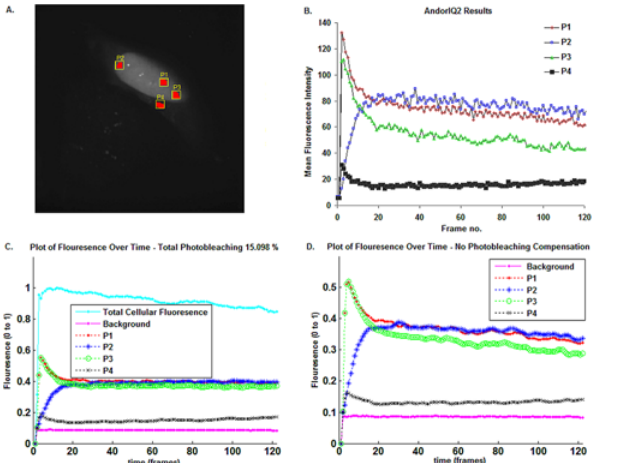
Fig 7. Comparison of Dendra2UBC9 protein trafficking obtained for both AndorIQ2 and MATtrack software. (A) The selected ROIs; (B) Dendra2UBC9 trafficking in HeLa cells analyzed using AndorIQ2; (C) The same sample analyzed using MATtrack; (D) Analysis using MATtrack with photobleaching compensation removed for direct comparison with AndorIQ2.